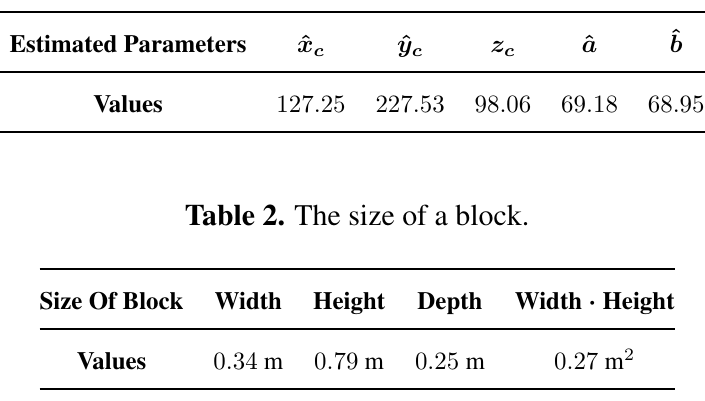
, Y , Z ) denotes the reference coordinate system. r r r , Y , Z ) . The red areas are e e e